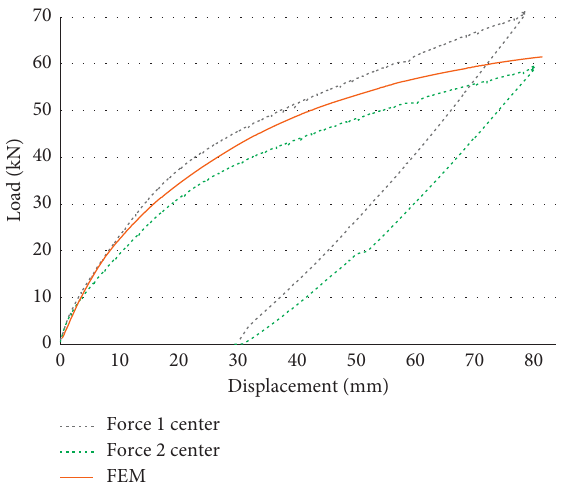
Figure 10: The comparison of the experimental and FEM load-displacement curves.